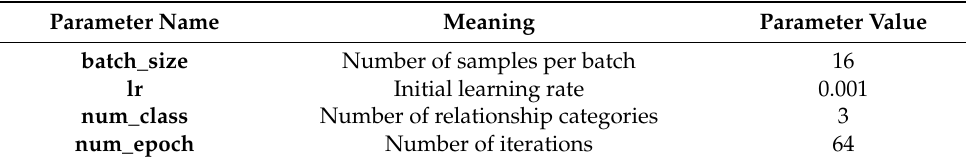
Table 9. Relation extraction experimental